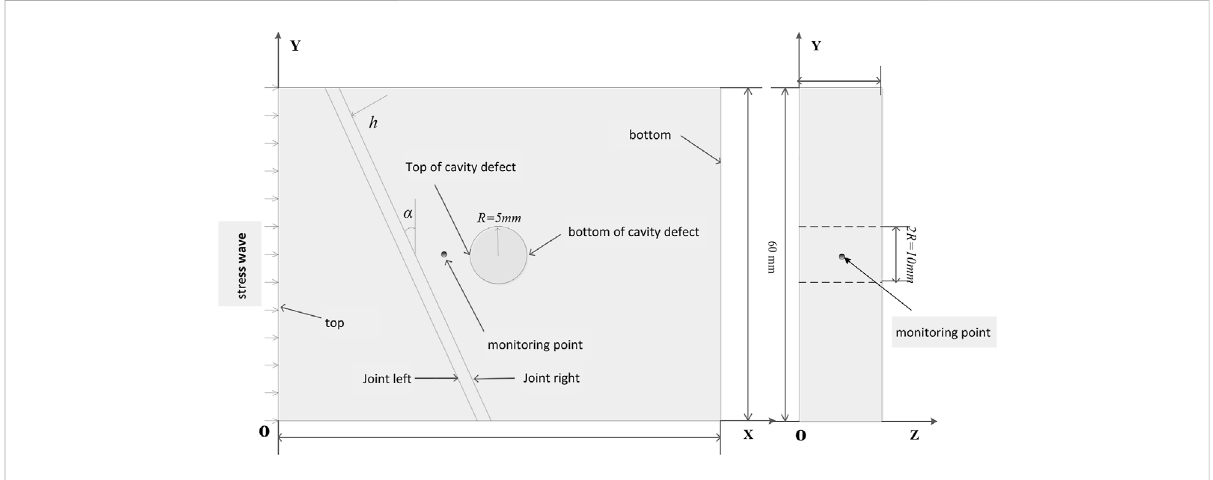
FIGURE 2 Numerical specimen.